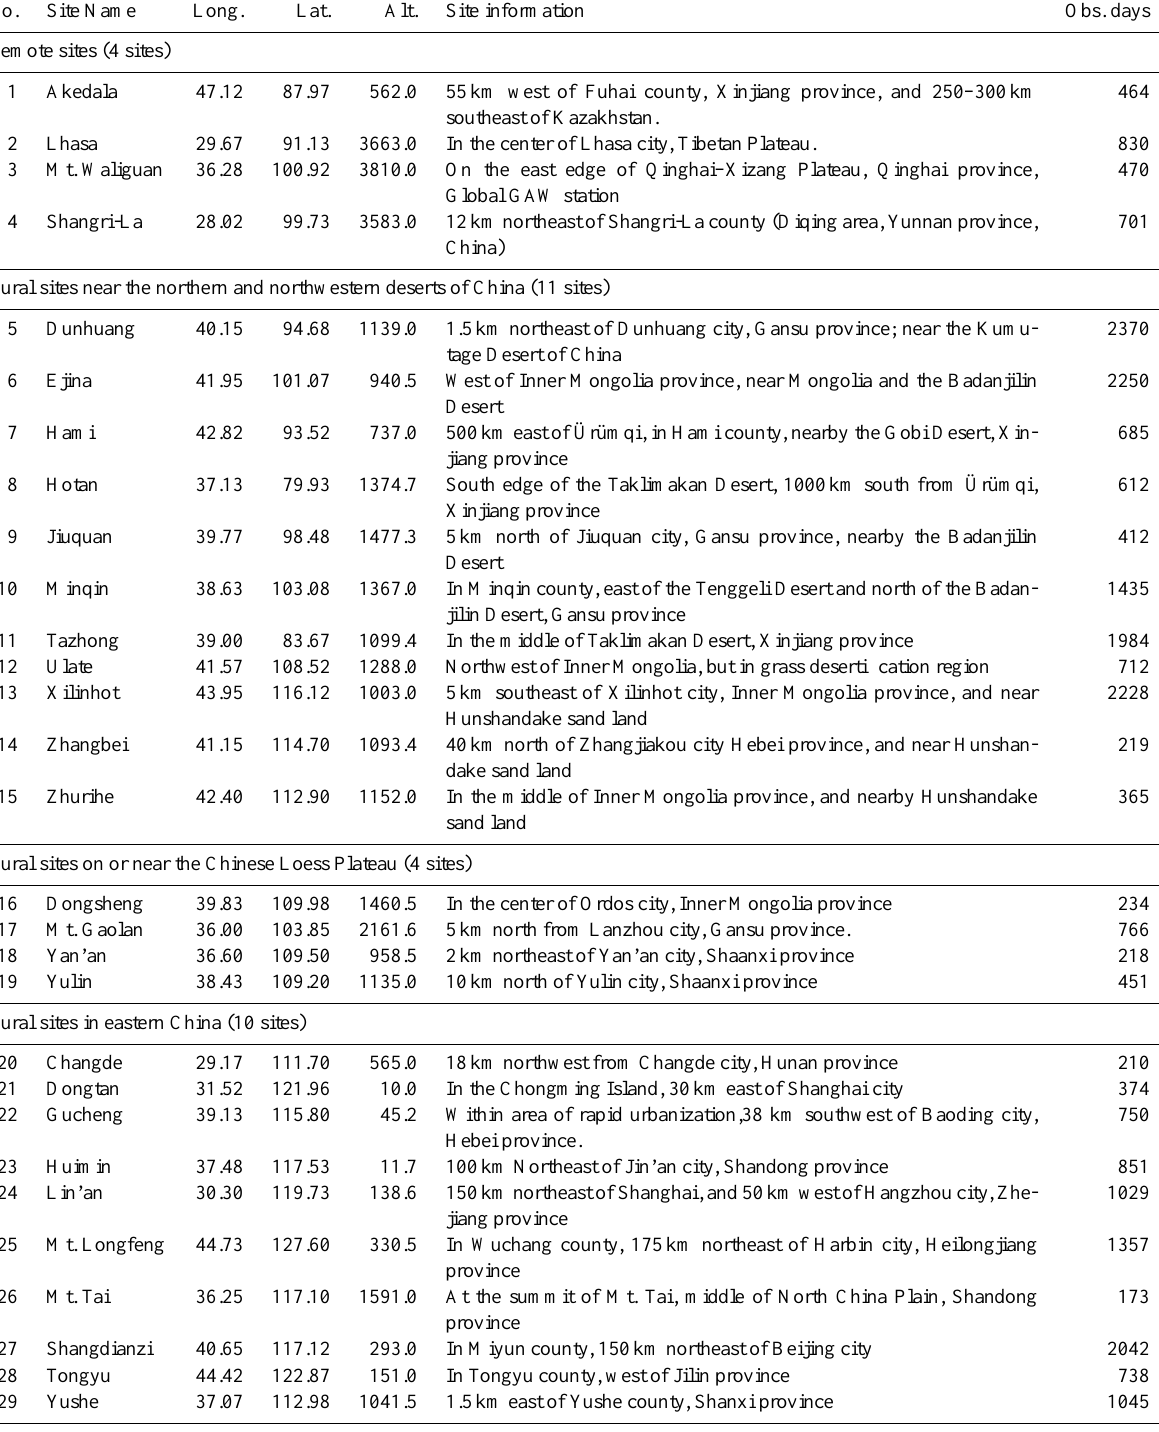
Table A1. Site information for the 50 CARSNET sites used in this